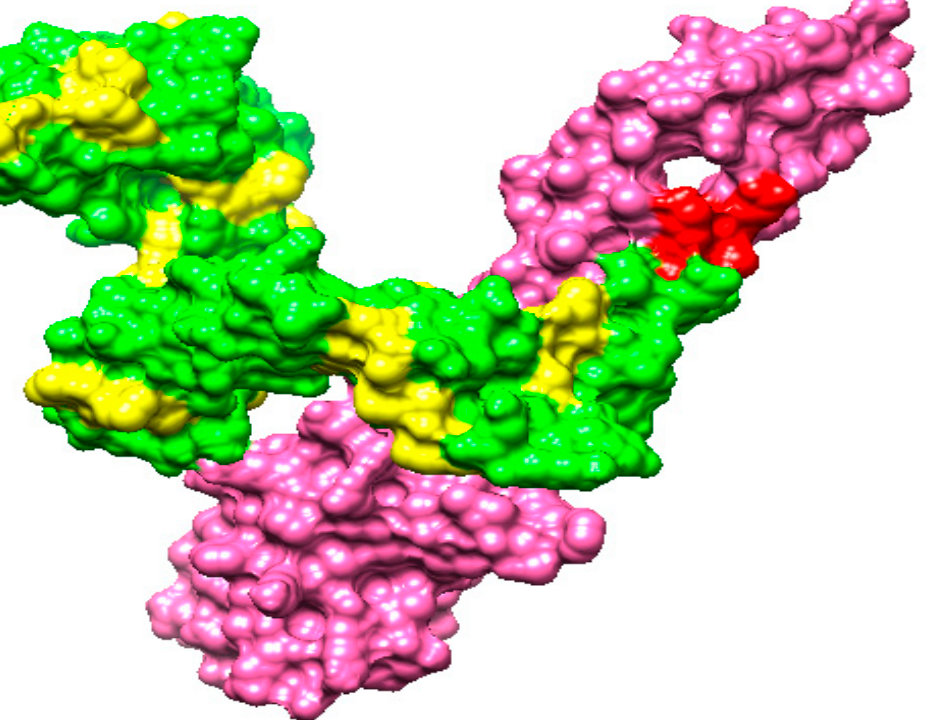
Figure 7. The GPGPG linkers (yellow), cholera toxin B subunit (pink), EAAAK linkers (red), and vaccine epitopes (green) are displayed in the 3D structure of the vaccine construct.